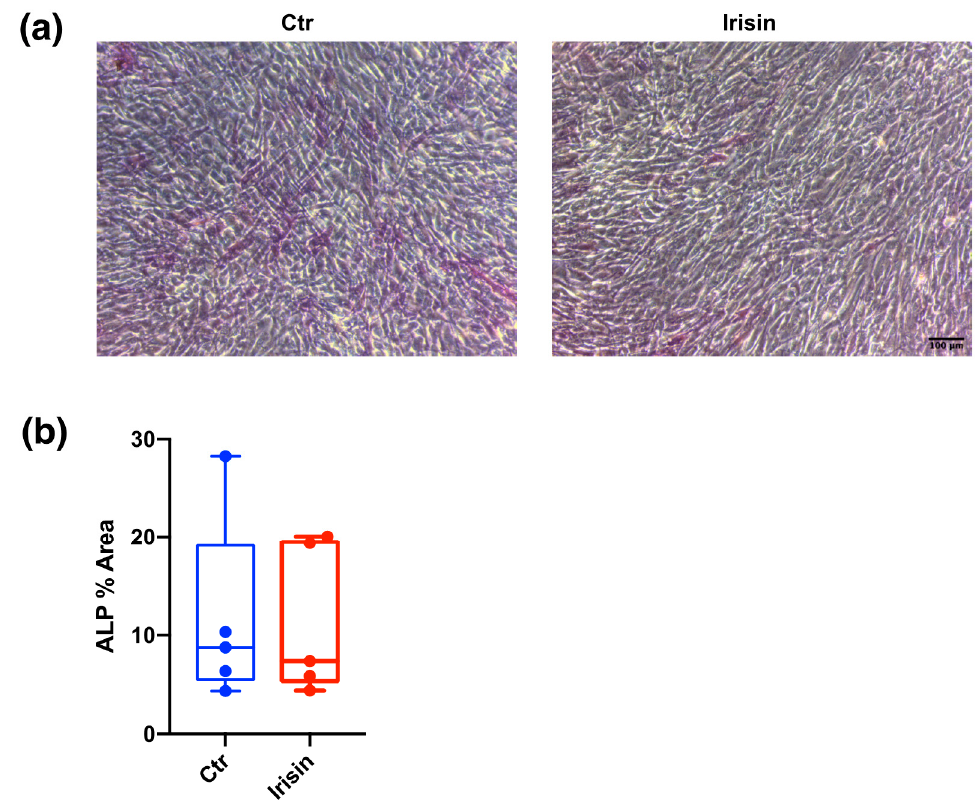
Figure 4. Alkaline phosphatase (ALP) expression in DBSCs. ( a ) ALP expression assayed by ALP cytochemical assay (purple staining) in DBSCs cultured in osteogenic conditions and treated with irisin or not (Ctr) for 7 days. Representative phase contrast pictures were chosen for the figure. Scale bar: 100 µ m. ( b ) The graph shows the quantification of ALP % area presented as box-and- whisker plots with median and interquartile ranges, from max to min, and is representative for five independent experiments performed in quadruplicates.